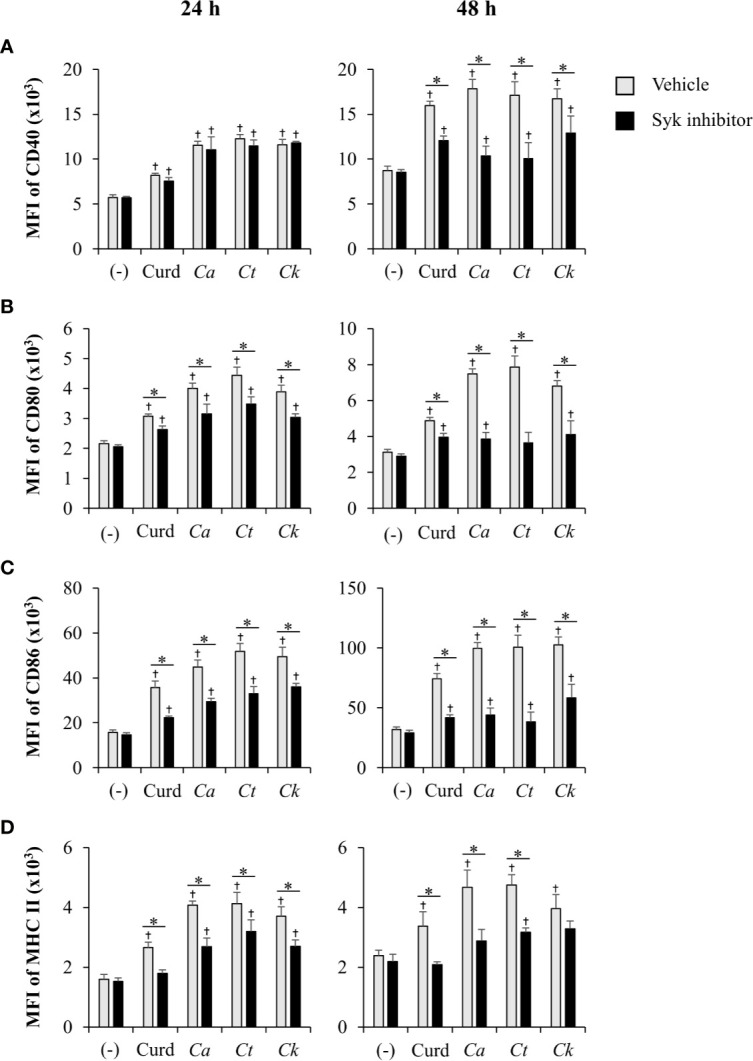
Inhibition of dendritic cell (DC) maturation by Syk inhibitor. Bone-marrow derived DCs (BMDCs) were pre-treated with 1 µM of Syk inhibitor for 30 min, and then the cells were stimulated with 25 µg/ml of curdlan and β-glucans isolated from C. albicans, C. tropicalis, and C. krusei for 24 h and 48 h. The geometric mean fluorescence intensity (MFI) of DC maturation markers (A) CD40, (B) CD80, (C) CD86, and (D) MHC class II on CD11c+ cells were determined using histogram analyses. n = 5; data are representative of two independent experiments. †
p < 0.05 compared with unstimulated BMDCs, *p < 0.05. (-), unstimulated BMDCs; Curd, curdlan; Ca, C. albicans; Ct, C. tropicalis; Ck, C. krusei.